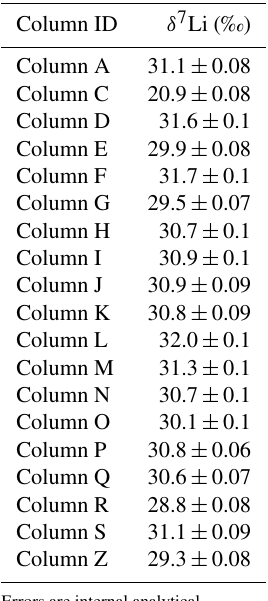
Figure A1. Lithium isotope composition of solutions from coral leaching, as a function of their Li / Ca ratio. In contrast to the dolo- stone, there is no relationship between δ 7 Li and Li / Ca. This could indicate that the isotopically light Li is bound to a fraction with a Li / Ca similar to that of aragonite. Error bars are within the symbol size, if not shown. Table A1. Column calibration using seawater samples.